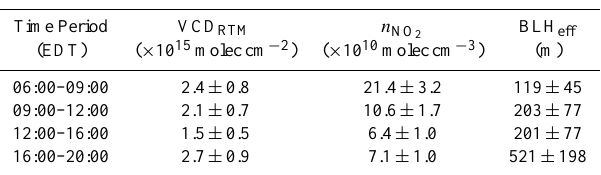
Table 3. Average VCD RTM , ground NO 2 , and BLH eff for selected time periods at